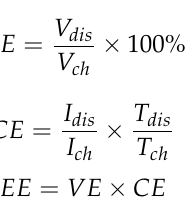
Figure 5. Compositions of the vanadium battery.